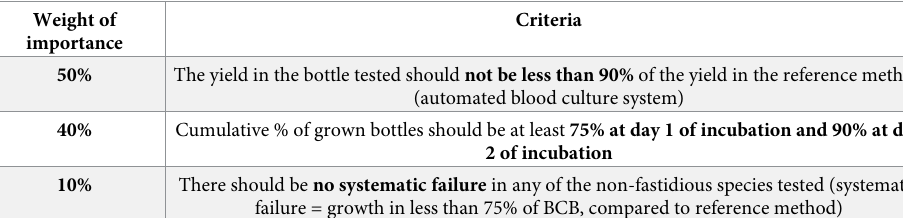
Table 2. Criteria for blood culture bottle performance, as defined by the mini-lab project.